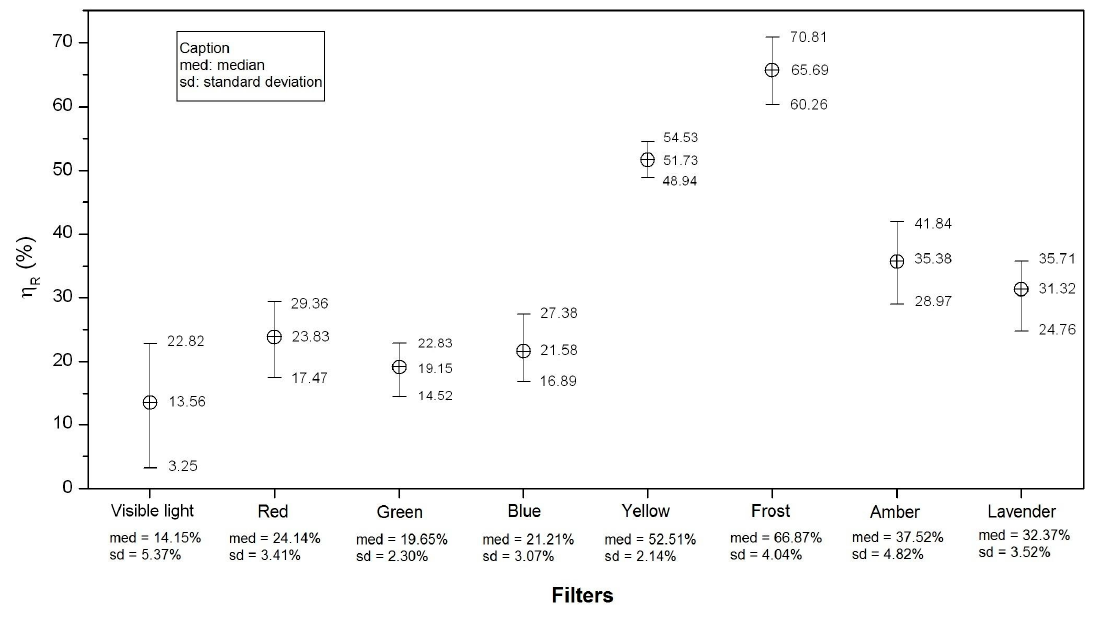
Figure 4. Comparison among the corrected relative efficiency of color filters. The values inside the box plot represent, from top to bottom, maximum value, mean value, and minimum value.